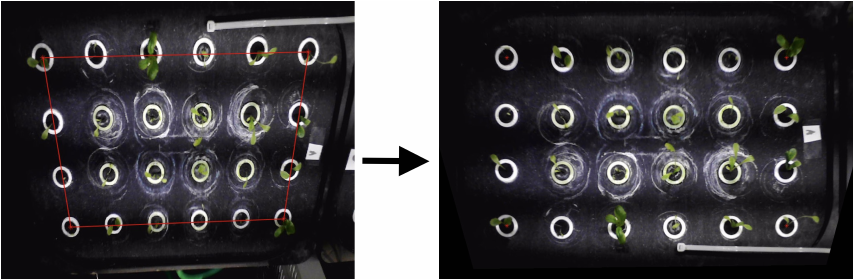
Figure 2. Full-tray image transformation and